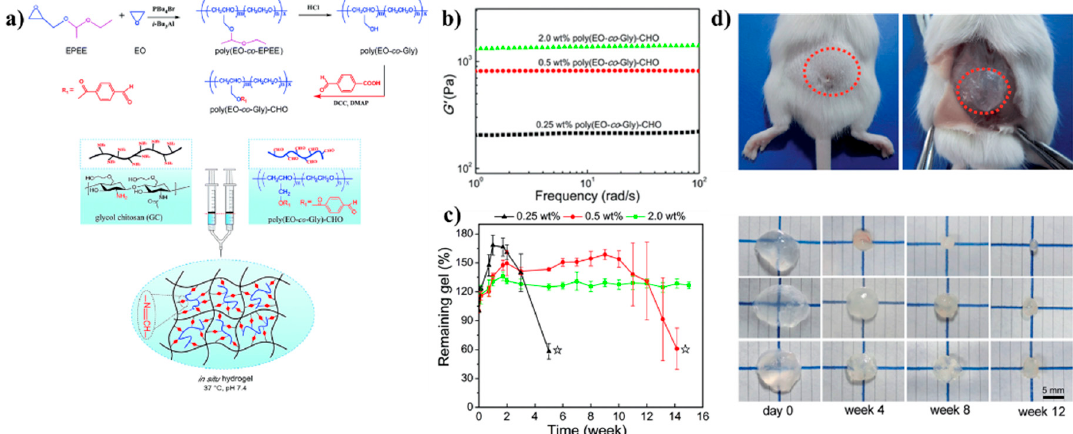
Figure 2. ( a ) Schematic representation of the formation of the hydrogel cross-linked by a Schiff base reaction between GC and poly(EO- co -Gly)-CHO; ( b ) G’ of the hydrogels containing different concentrations of poly(EO- co -Gly)-CHO depending on the frequency. The final concentration of GC was fixed at 1.5 wt %; ( c ) in vitro degradation of GC/poly(EO- co -Gly)-CHO hydrogels fabricated with different concentrations of cross-linker in PBS containing 1 mg mL − 1 lysozyme at 37 °C; ( d ) in vivo degradation tests of the hydrogels. Photographs of the remaining hydrogels containing the indicated concentrations of poly(EO- co -Gly)-CHO: 0.25 wt % ( top ), 0.5 wt % ( medium ), and 2.0 wt % ( bottom ) removed from ICR mice after 0–12 weeks. Reprinted with permission [35]. Copyright 2015, Royal Society of Chemistry.